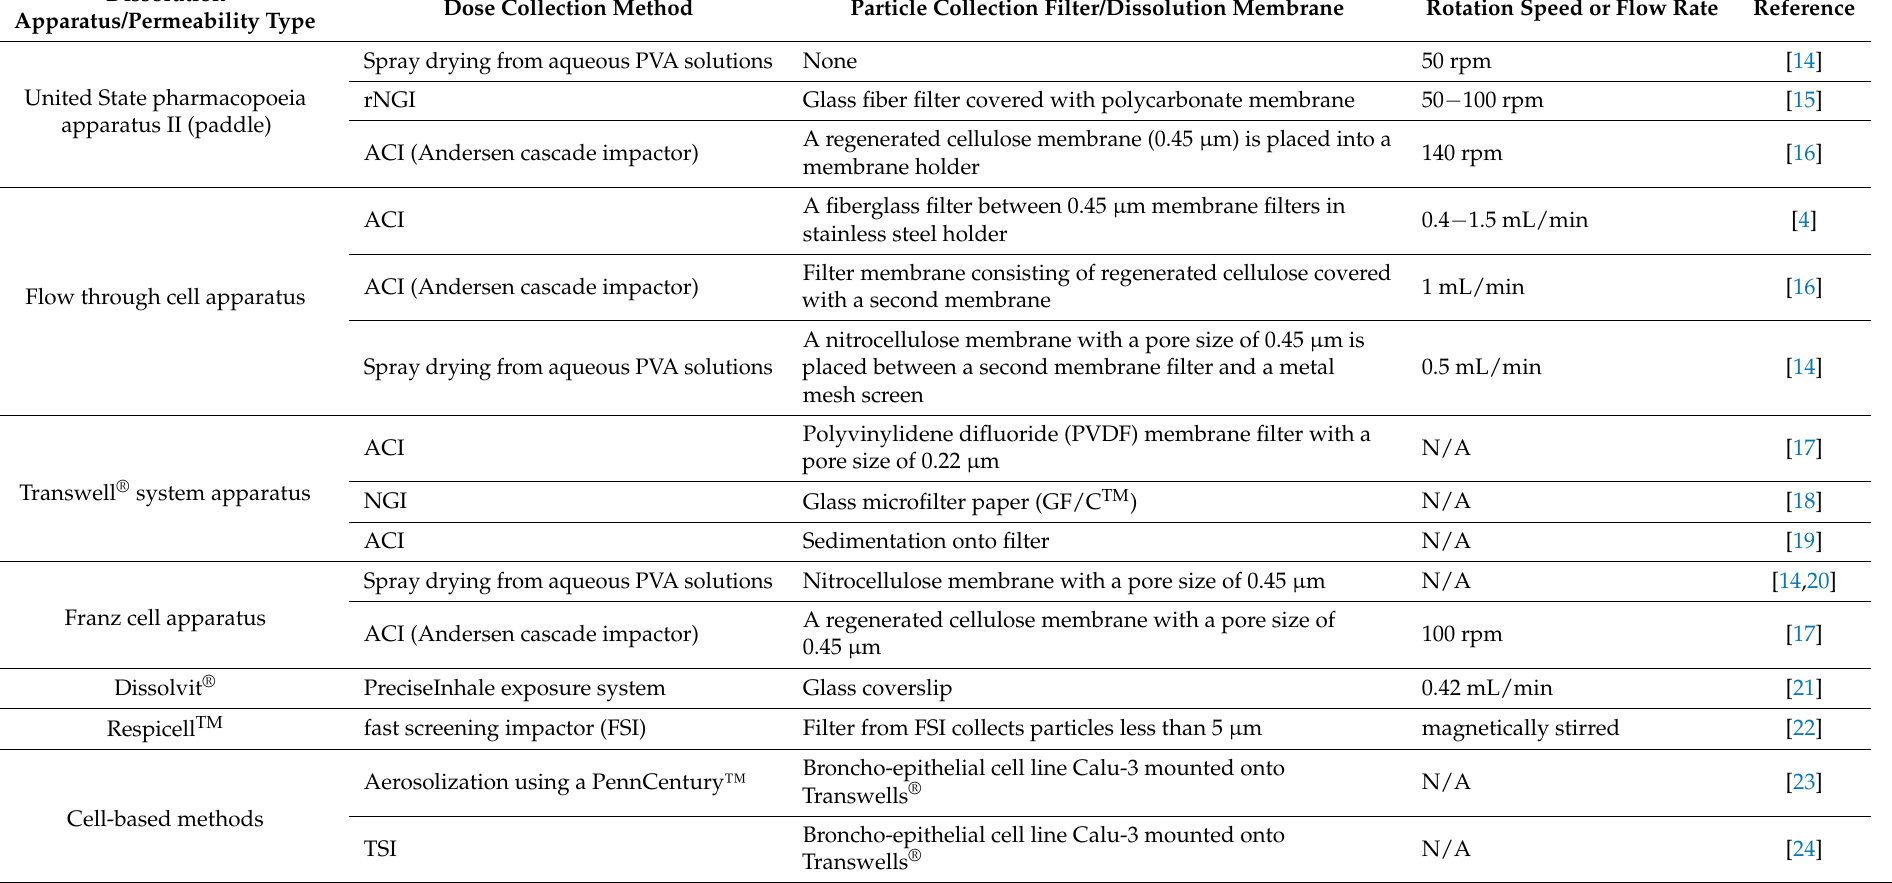
Table 1. Dissolution testing methods employed to assess the dissolution of fine particle doses of